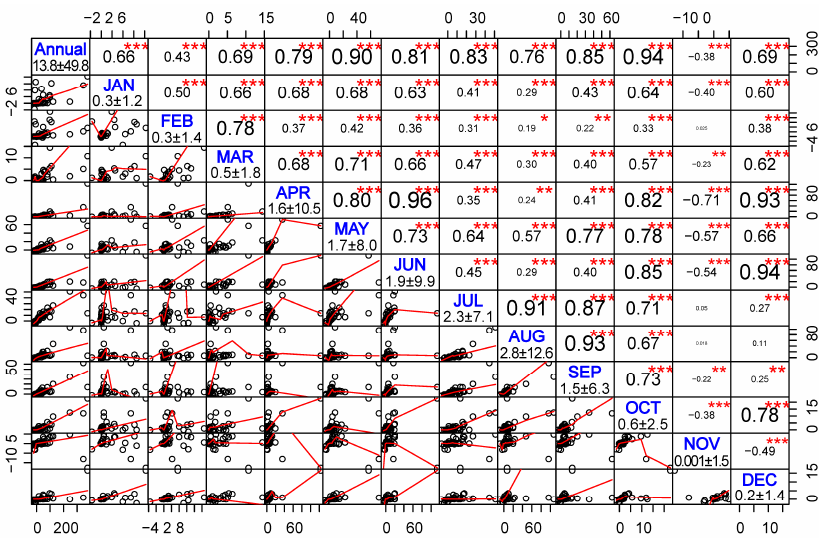
Figure 3. Correlation coefficient matrix of observed annual and monthly CH 4 fluxes. The diagonal panels represent the row and column heads, the numbers were the annual or monthly flux (mean ± standard deviation, g CH 4 m − 2 yr − 1 or g CH 4 m − 2 month − 1 ). The numbers on x and y axis are fluxes whose unit is g CH 4 m − 2 yr − 1 for annual flux and g CH 4 m − 2 month − 1 for monthly flux. The lower panels show the scatter plots (red lines are fitted lines of local regression) while the upper panels report the correlation coefficients. *** indicates significance at p < 0.001, ** indicates significance at p < 0.01, * indicates significance at p < 0.05. The sample size is 154.